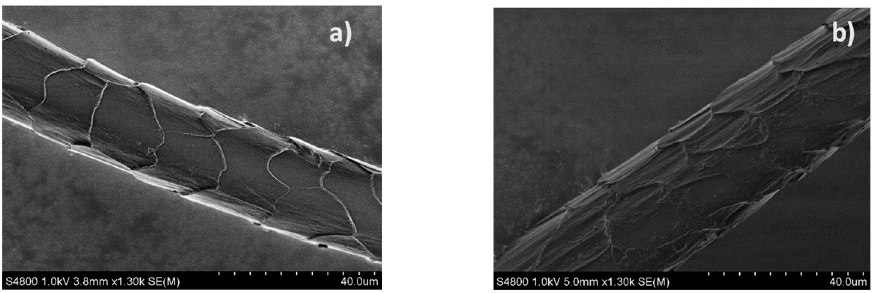
Figure 15. SEM images of the reference ( a ) and UV-aged wool fiber ( b ).